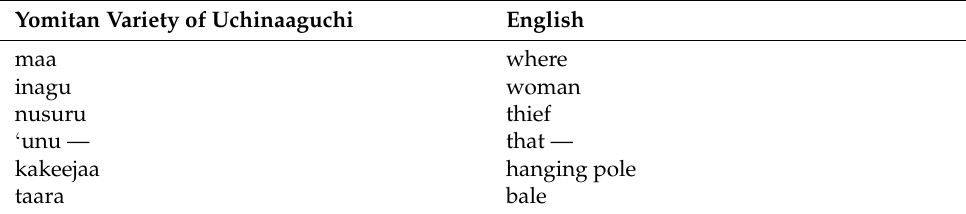
Table 6. Vocabulary from the story.